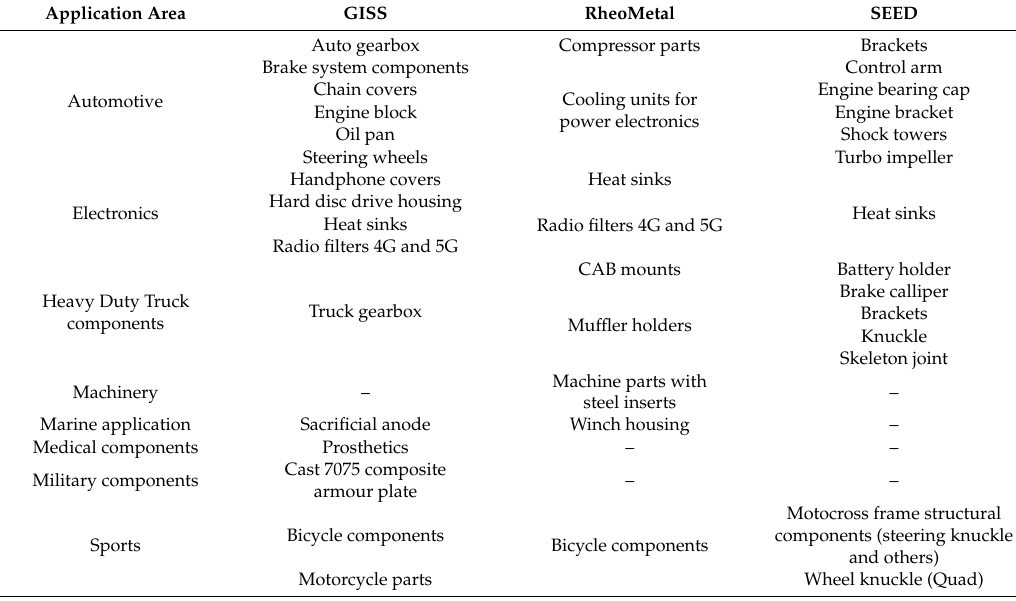
Table 3. Collation of components in production